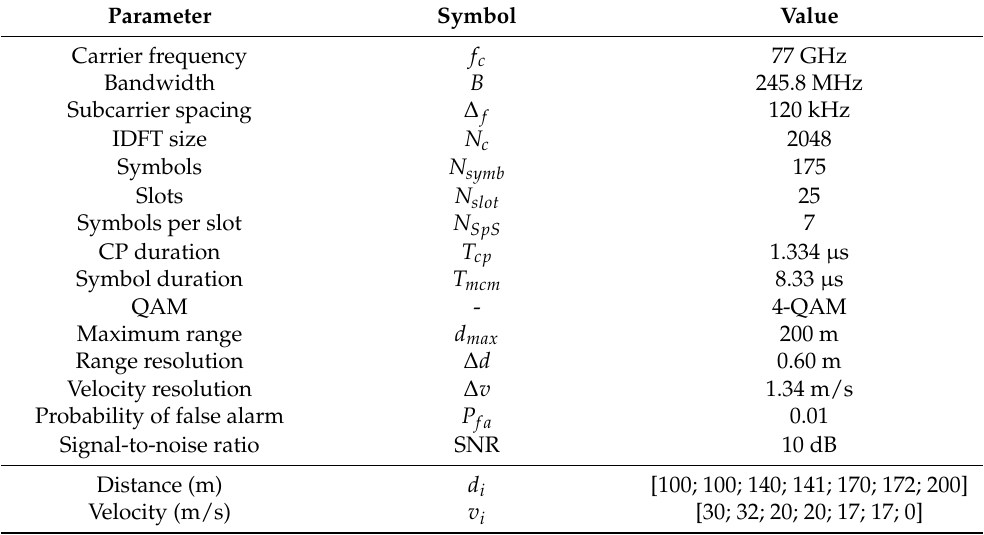
Table 3. Simulation